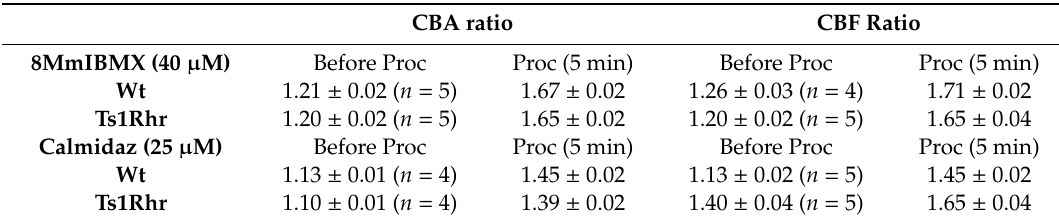
Table 4. E ff ects of procaterol stimulation on CBF and CBA ratio in the presence of 8MmIBMX and calmidazolium